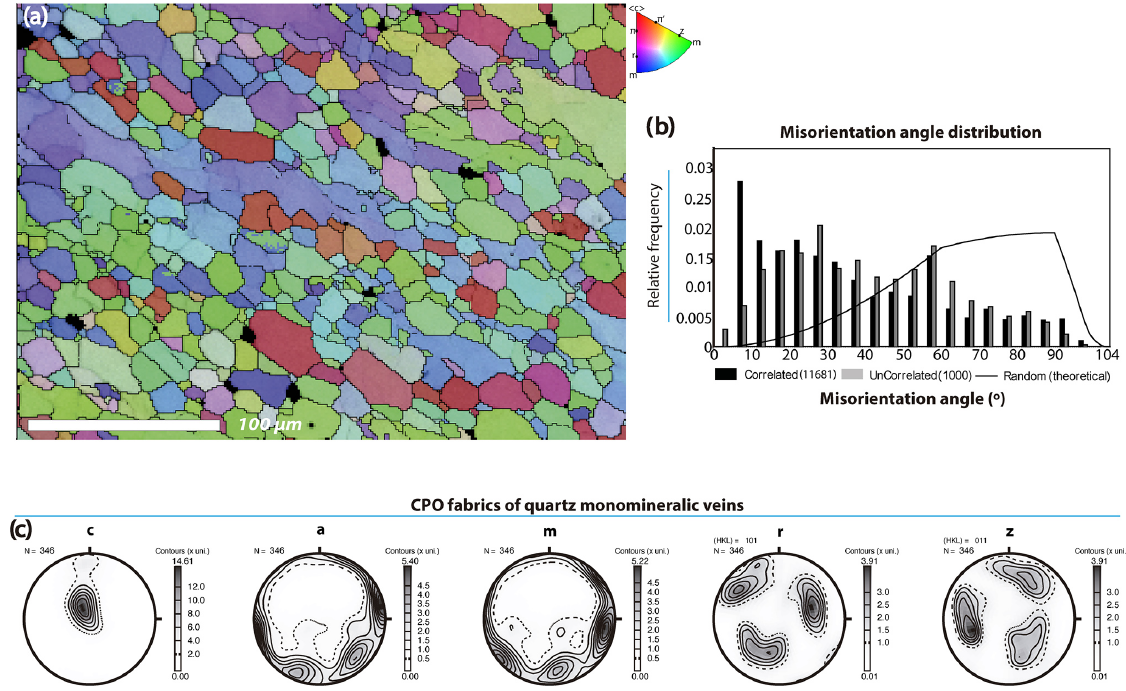
Figure 12. (a) EBSD inverse pole figure map with respect to the normal of the S foliation of a quartz monomineralic vein. (b) Misorientation angle distribution of quartz in the vein. (c) Pole figures of the crystallographic orientation of quartz grains included in (a)